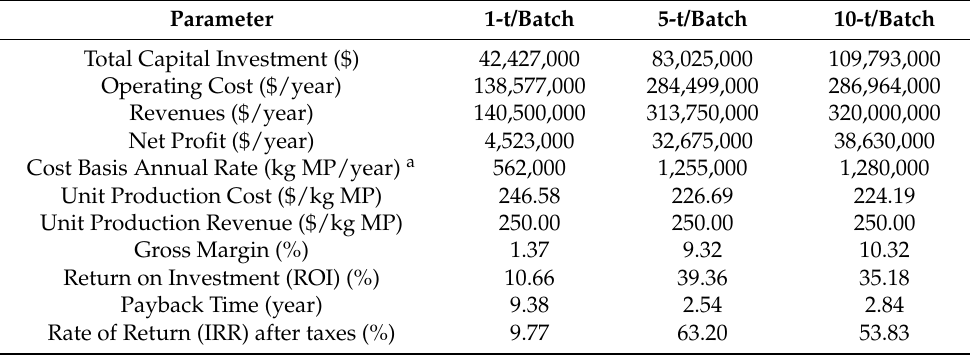
Table 6. Economic performance summary for different production